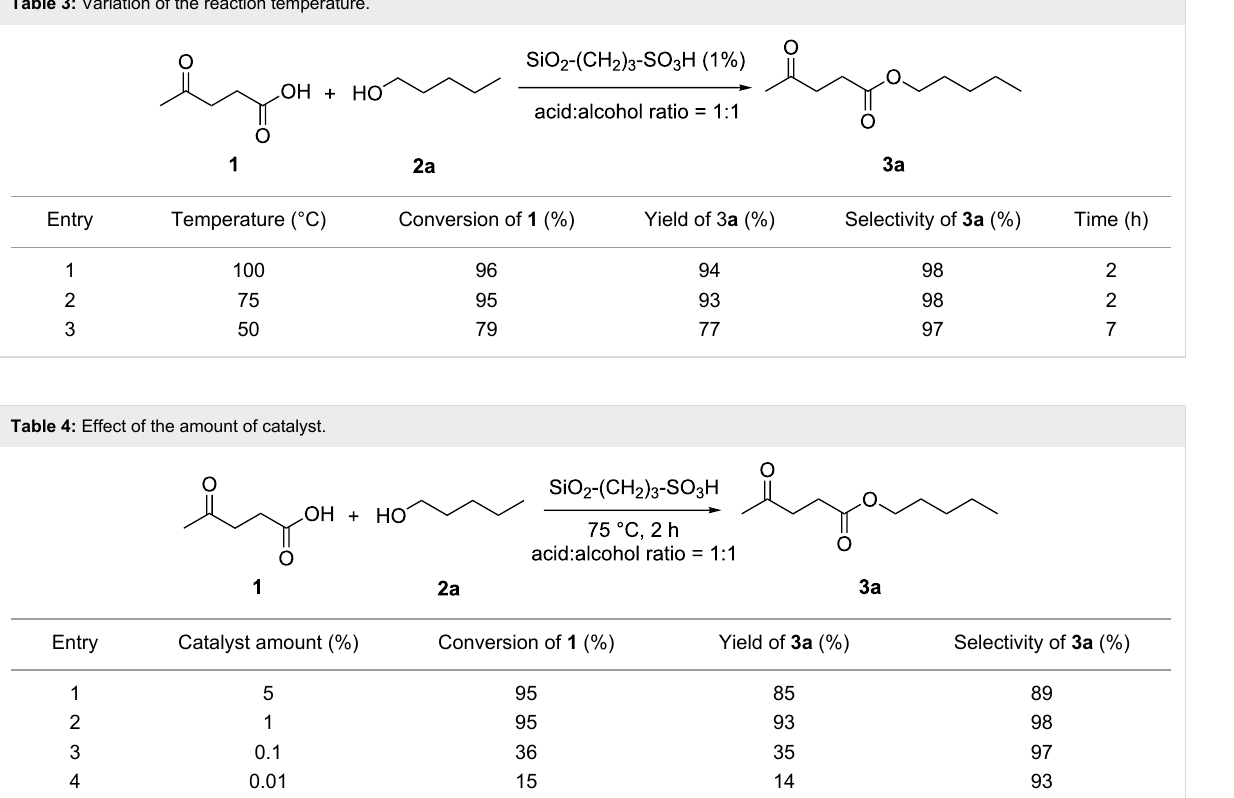
Table 3: Variation of the reaction temperature.